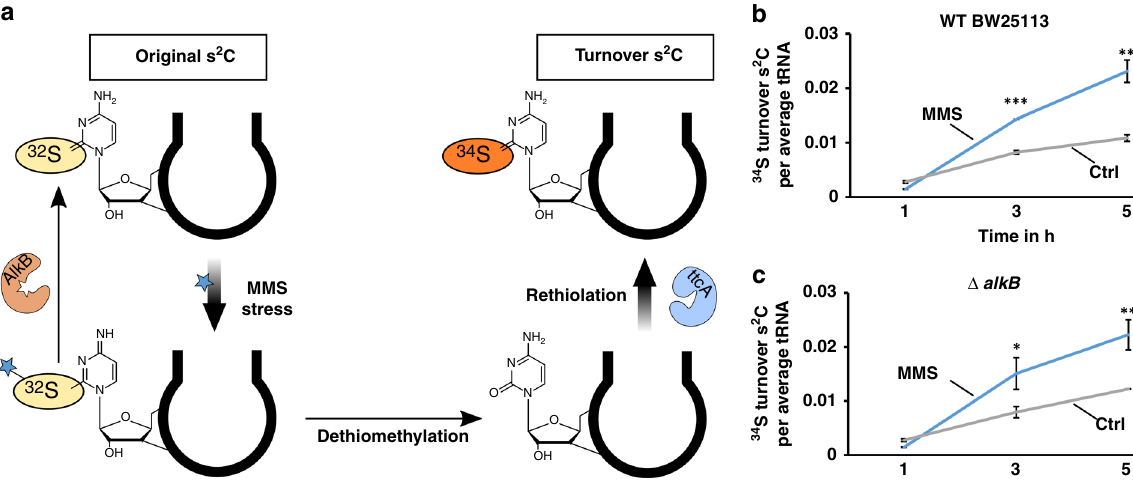
Fig. 5 Pulse-chase NAIL-MS analysis of turnover s 2 C after 20 mM MMS exposure in WT BW25113 and E. coli Δ alkB knockout strain. a Concept of turnover s 2 C generation and its detection by NAIL-MS. b Abundance of [ 34 S] turnover s 2 C in WT BW25113 during recovery after MMS stress (20 mM) and unstressed control. c Abundance of [ 34 S] turnover s 2 C in the Δ alkB strain during recovery after MMS stress (20 mM) and unstressed control. All experiments are from n = 3 biol. replicates and error bars re fl ect standard deviation. p -values from student t-test (equal distribution, two-sided): * p < 0.05, ** p < 0.01 and *** p < 0.001. Source data are provided as a Source Data fi